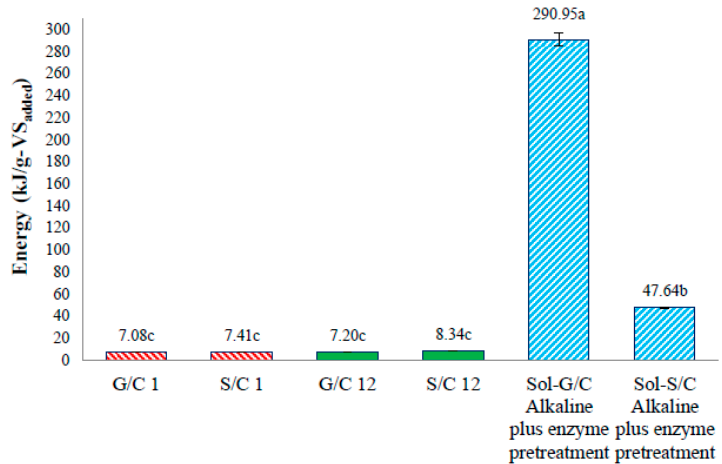
Figure 6. Energy production under the optimum conditions of a co-digestion of grass (G) with cow dung (C) and silage (S) with cow dung by self-fermentation (G/C1 and S/C1, respectively), bioaugmentaion (G/C12 and S/C12, respectively), and solid residues from a co-digestion of grass with cow dung (Sol-G/C) and silage with cow dung (Sol-S/C).